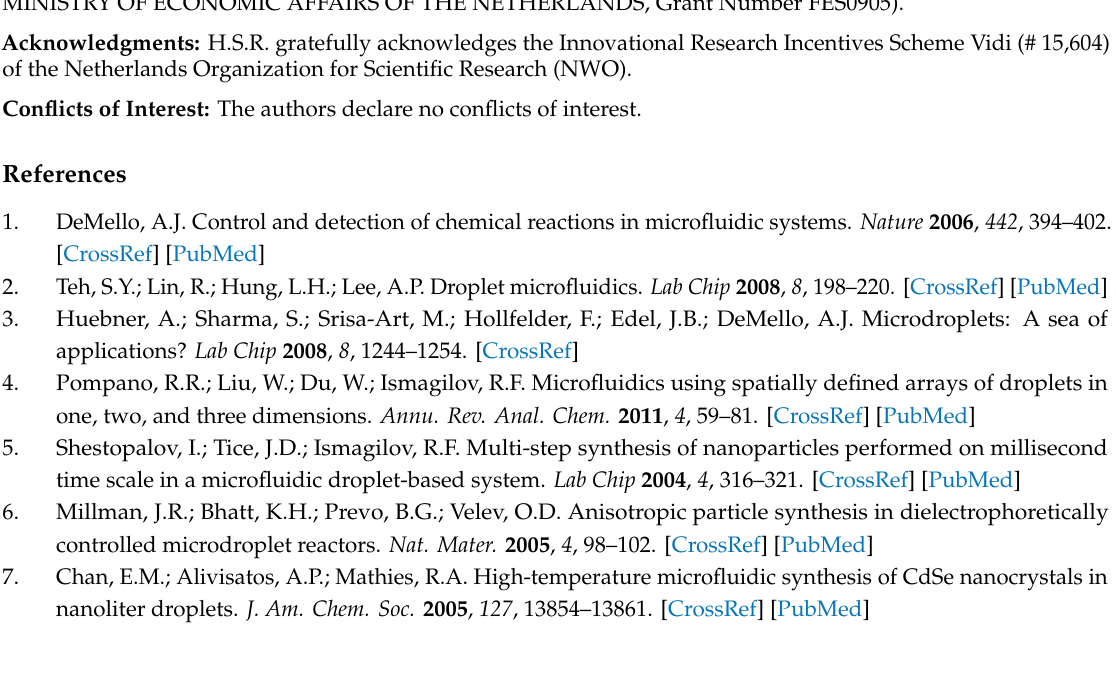
Figure S1: Volume loss of w / o droplets in a non-treated PDMS